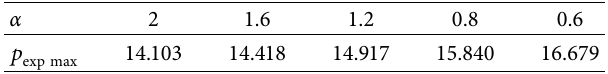
Table 5: Maximum critical hydraulic pressure under different brittleness coefficients